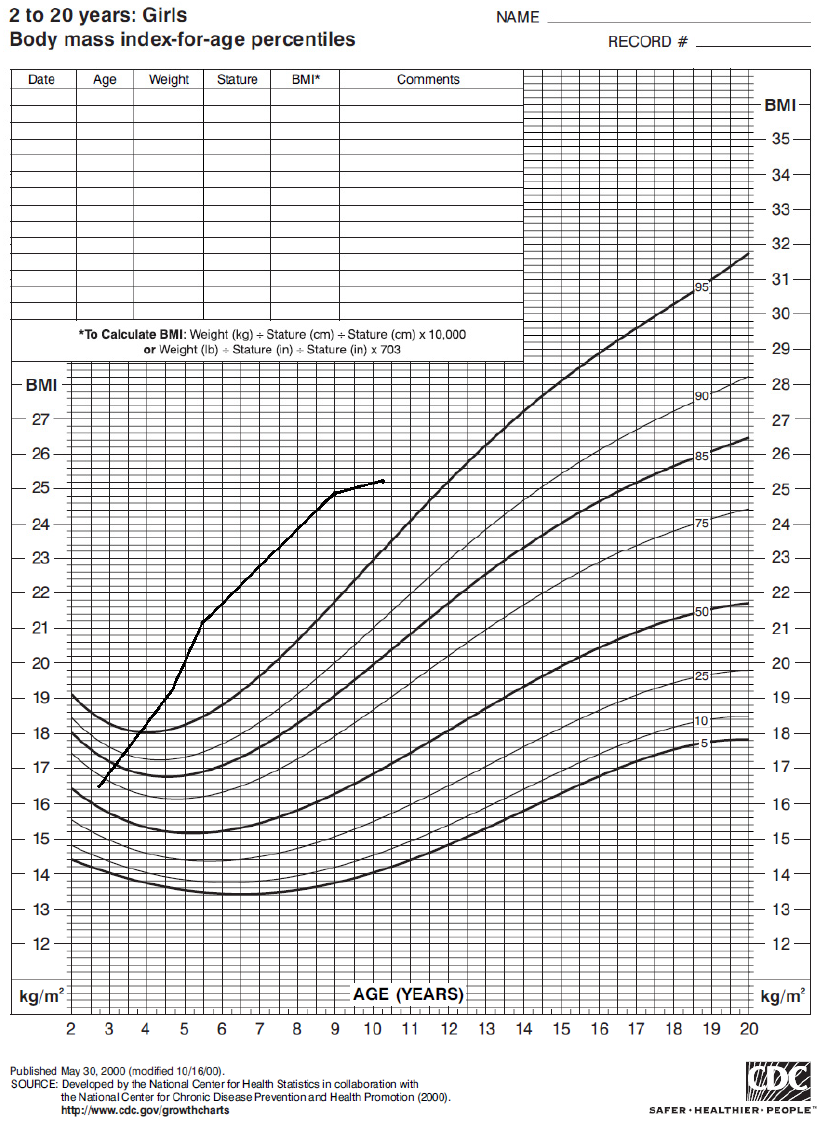
Figure 2. Body mass index of our case from 2 to 10 years of age according to CDC 2000 growth chart.